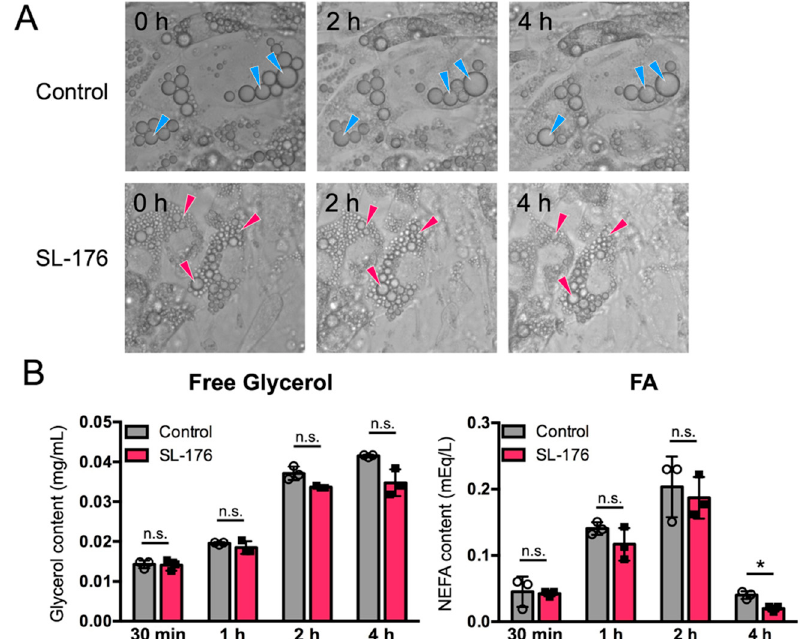
Figure 5. PPM1D-inhibited adipocytes are resistant to lipolysis. ( A ) Cell images during lipolysis assay. The cells were differentiated for 8 days followed by treatment with SL-176 for 7 days; then, the cells were incubated with lipolysis buffer for 2 and 4 h. Arrowheads show the representative LDs that decreased their size. ( B ) The amount of free glycerol and FA were analyzed after 7 days of inhibition of PPM1D in mature 3T3-L1 white adipocytes, then the cells were incubated with lipolysis buffer for 1 h, followed by incubated with maintenance buffer for the indicated time: 30 min and 1, 2, and 4 h. Data represents the mean ± S.D. of three independent experiments. Significance was analyzed by using Student’s t-test. * p < 0.05; n.s. not statistically significant.